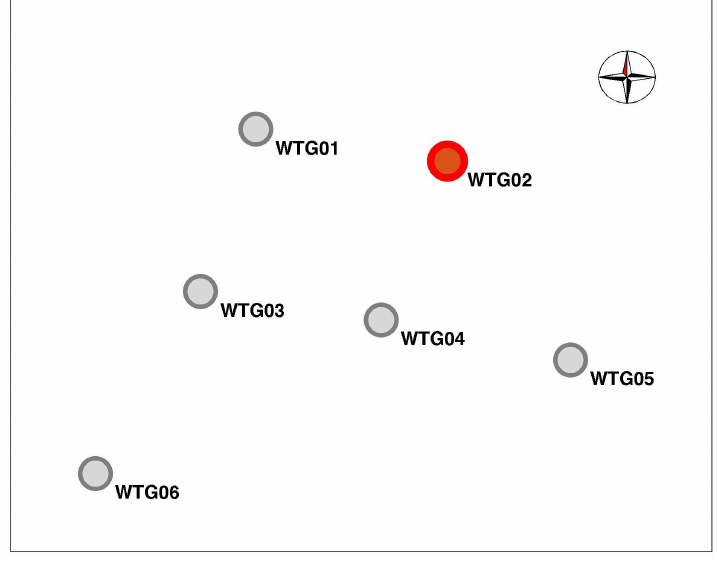
Figure 1. The layout of Wind Farm